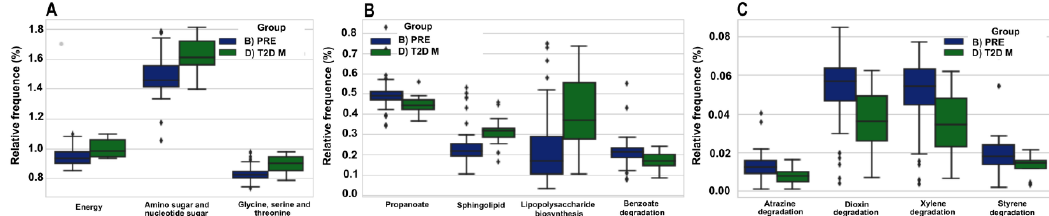
Figure 6. Comparative prediction of the functional metagenome of the gut bacterial microbiota. The using PICRUSt for the bacterial communities. The Y -axis shows the relative abundances (%) of the gene content prediction, and the X -axis shows PRE (blue color) and T2D−M (green color) groups. The significant metabolic pathways shown at the bottom of each graph are: ( A ) Energy metabolism, amino sugar and nucleotide sugar metabolism, and glycine serine and threonine metabolism; ( B ) Propanoate metabolism, sphingolipid metabolism, lipopolysaccharide biosynthesis, and Benzoate degradation, and ( C ) Atrazine, dioxin, xylene, and styrene degradations. The box-plots show the interquartile ranges (bottom and top of boxes), medians (middle lines in the boxes), and the lowest and highest values for the first and third quartiles. Dots represents single individuals, and each category is identified by colors (see Table